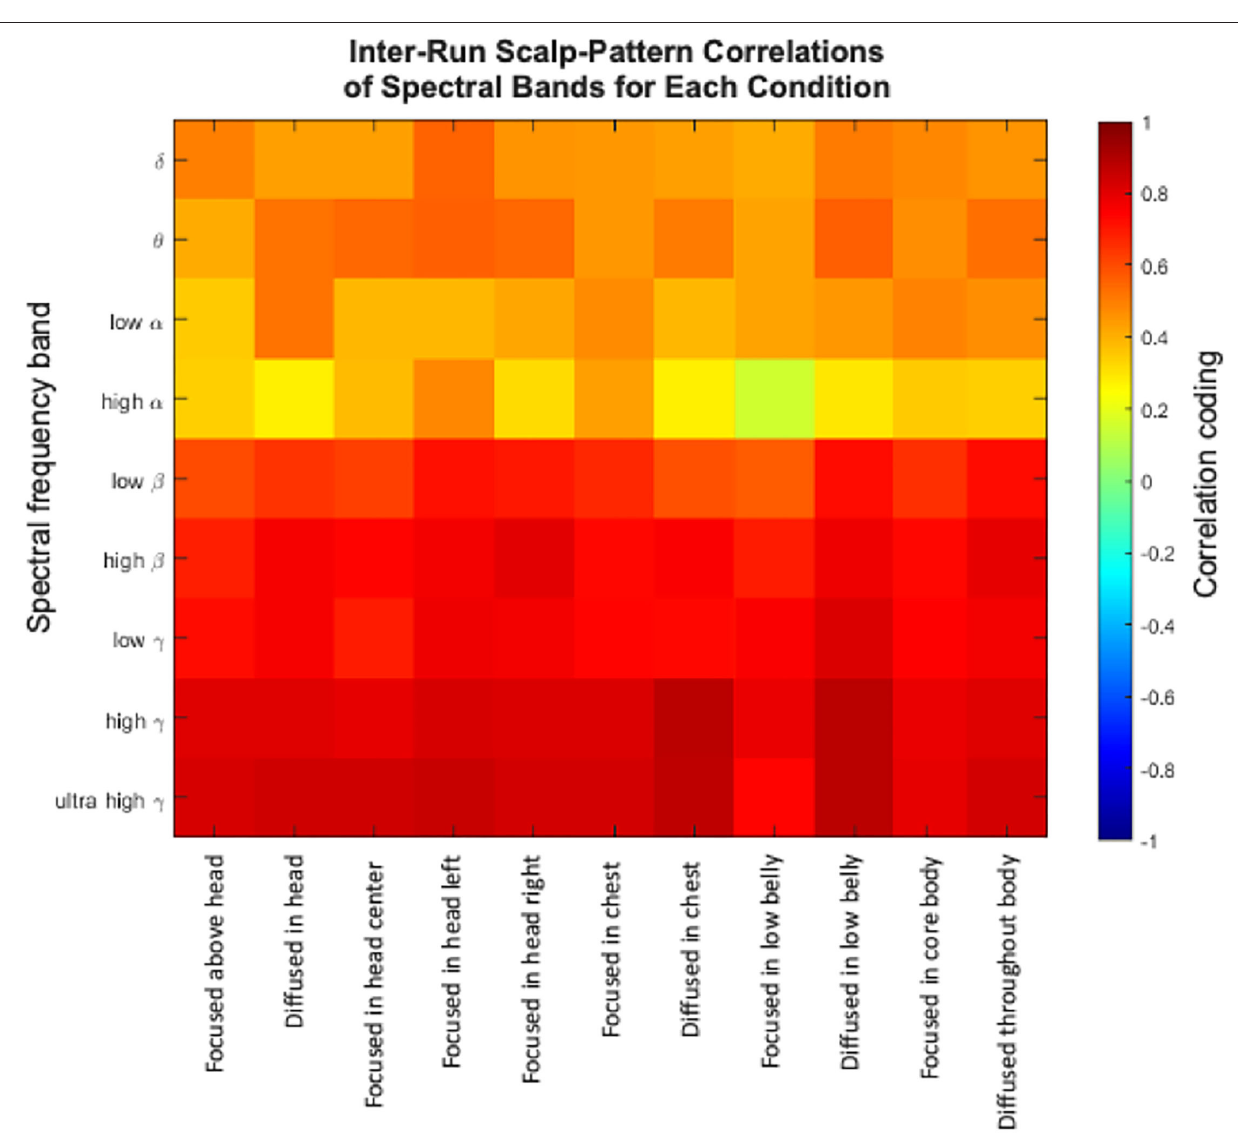
FIGURE 5 | Average inter-run correlations for eight